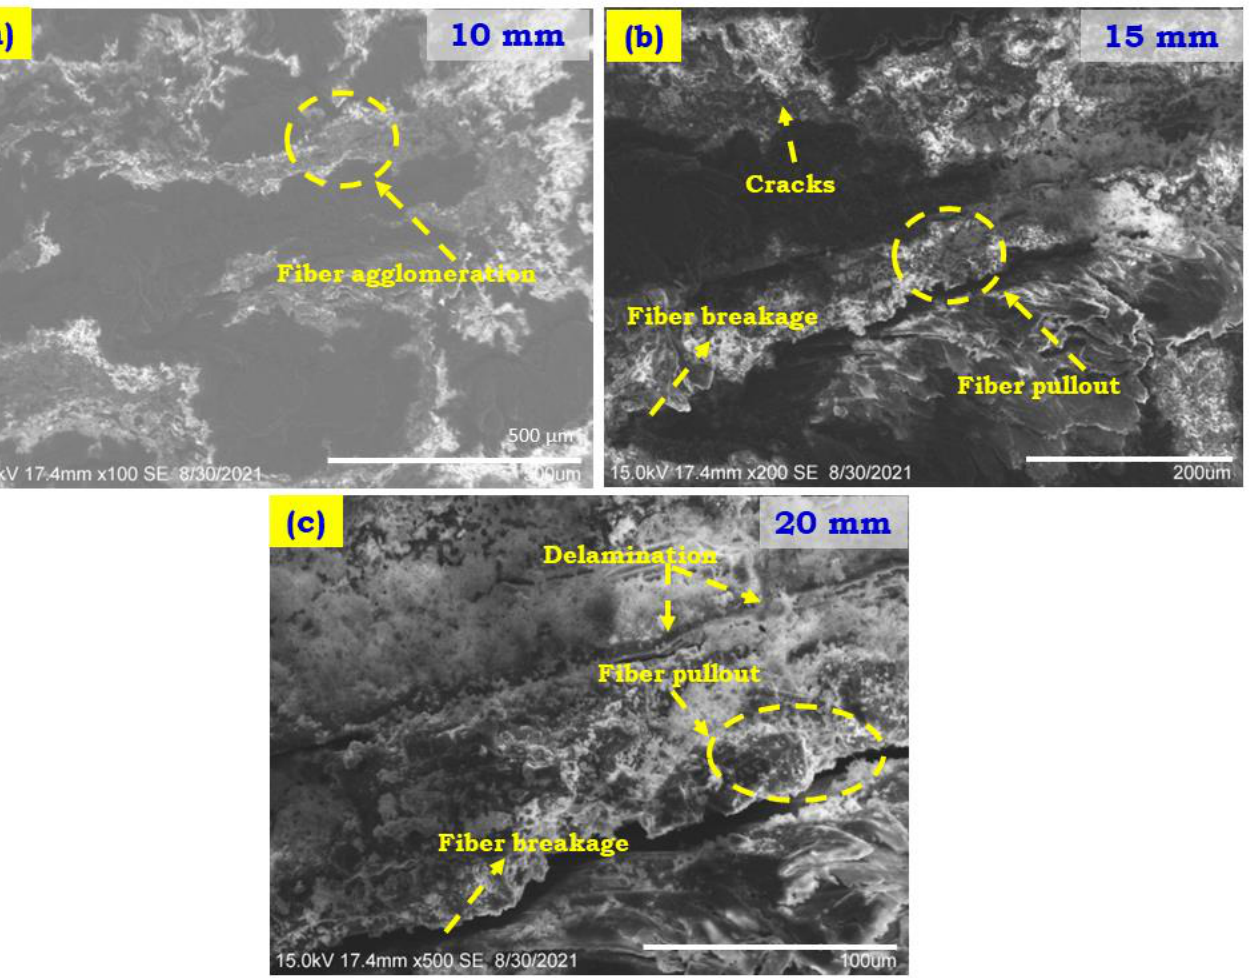
Figure 12. SEM morphologies of flexural fractured samples of 10, 15, and 20 mm PALF fiber length.